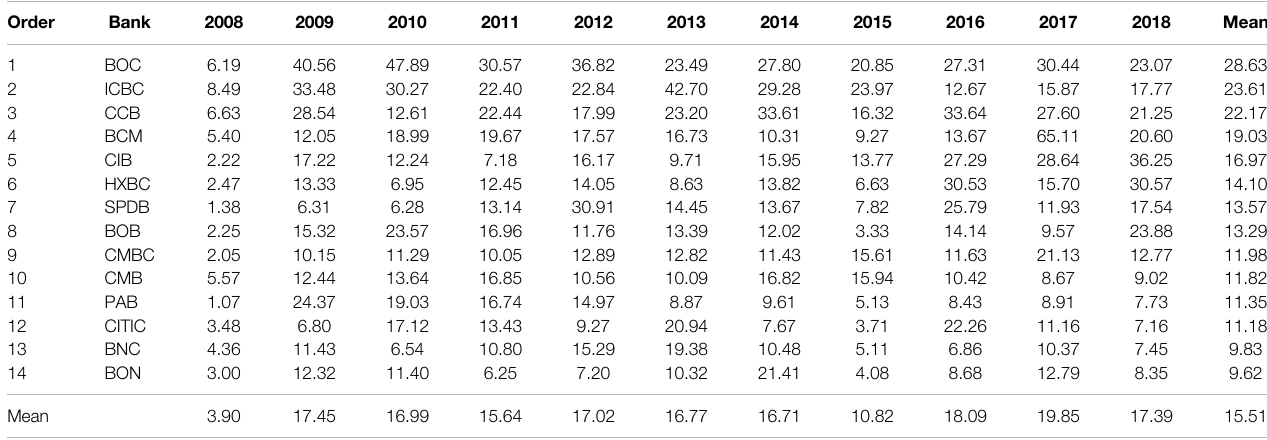
TABLE 11 | Total spillover effects of banks. Order